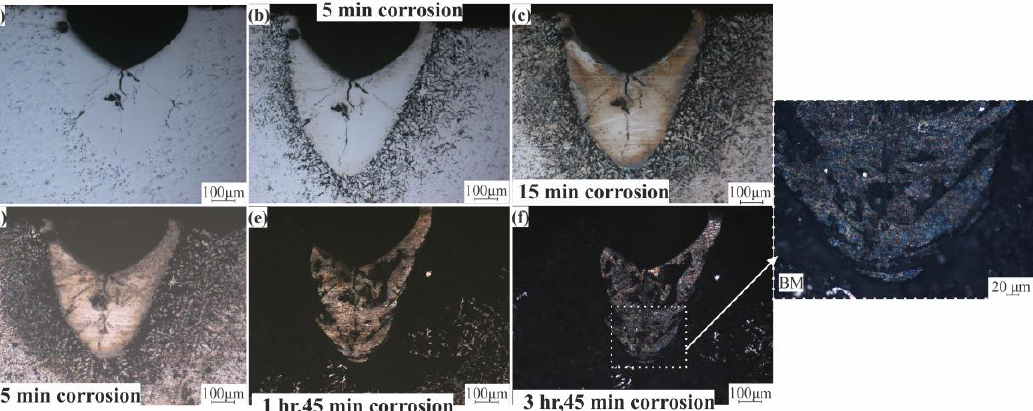
Figure 15. Intergranular corrosion of AA7075-FeNi after ( a ) laser, ( b ) 5 min, ( c ) 15 min, ( d ) 45 min, ( e ) 1 h and 45 min, and (f) 3 h and 45 min.